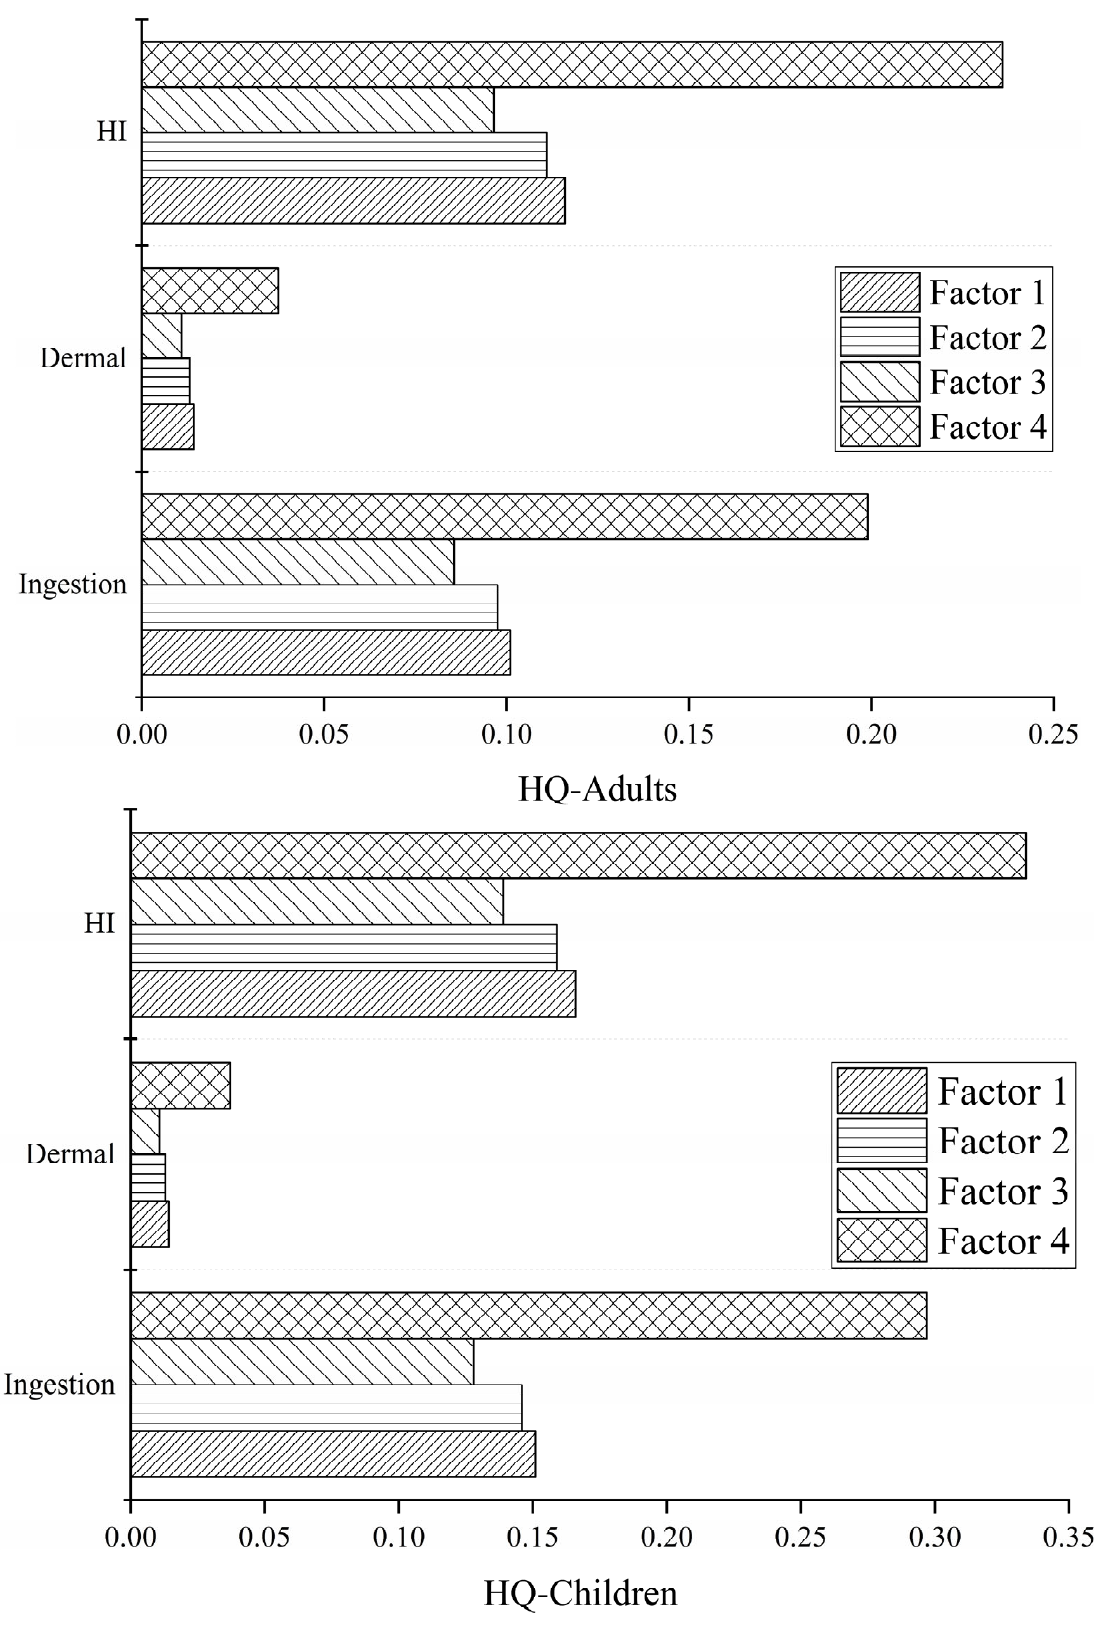
Figure 8. HI and HQ values for adults and children.